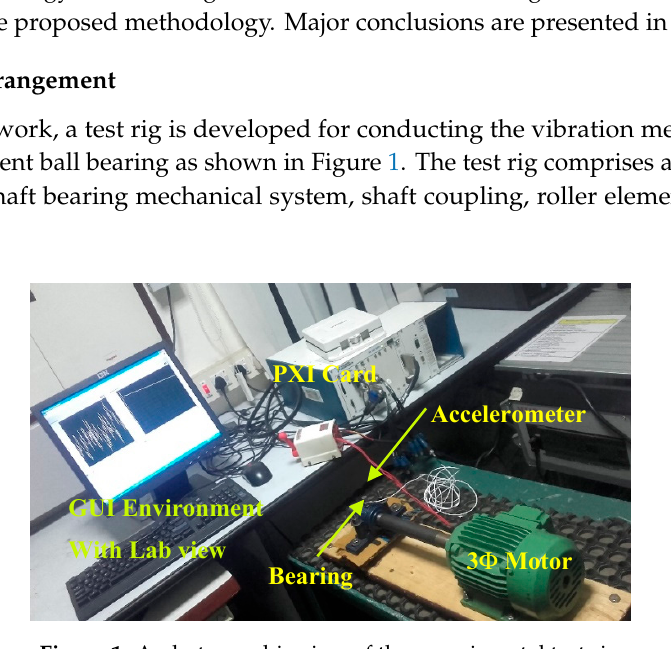
Figure 1. A photographic view of the experimental test rig.